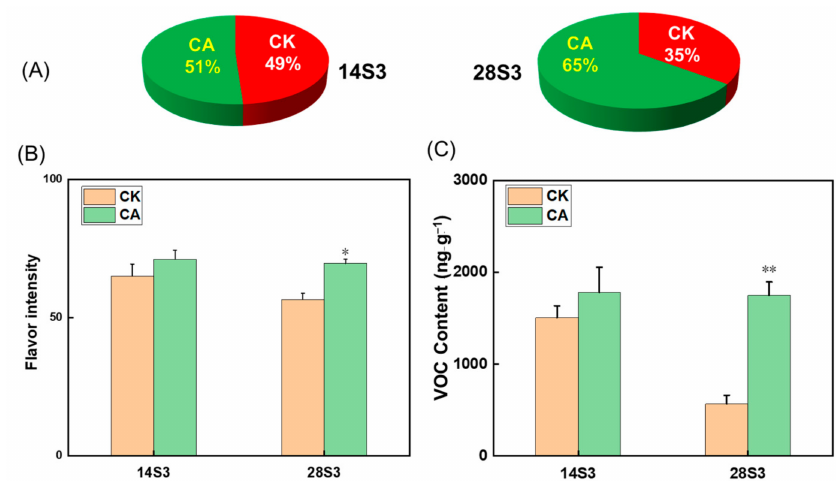
Figure 2. Sensory evaluation and VOC content of peach fruit during three shelf-days after cold storage. ( A ) Aroma preference of the fruit; ( B ) Flavor intensity of the fruit; ( C ) Total content of the key volatile compounds. The sensory evaluation of peach fruit was performed by 30 panelists. The key volatile compounds were listed in Table S1 with bold highlighted. Data are expressed as the means ± standard error of three biological replicates, the * indicated the statistical significance of the two samples with the unpaired Student’s t -test (* p < 0.05, ** p < 0.01). Three main organic acids and soluble sugars were detected under cold storage plus shelf-life (Table 1). Sucrose occupied nearly 80% of total soluble sugars in peach fruit and decreased from 151.1 mg × g − 1 to 104.80 mg × g − 1 when storage was prolonged to